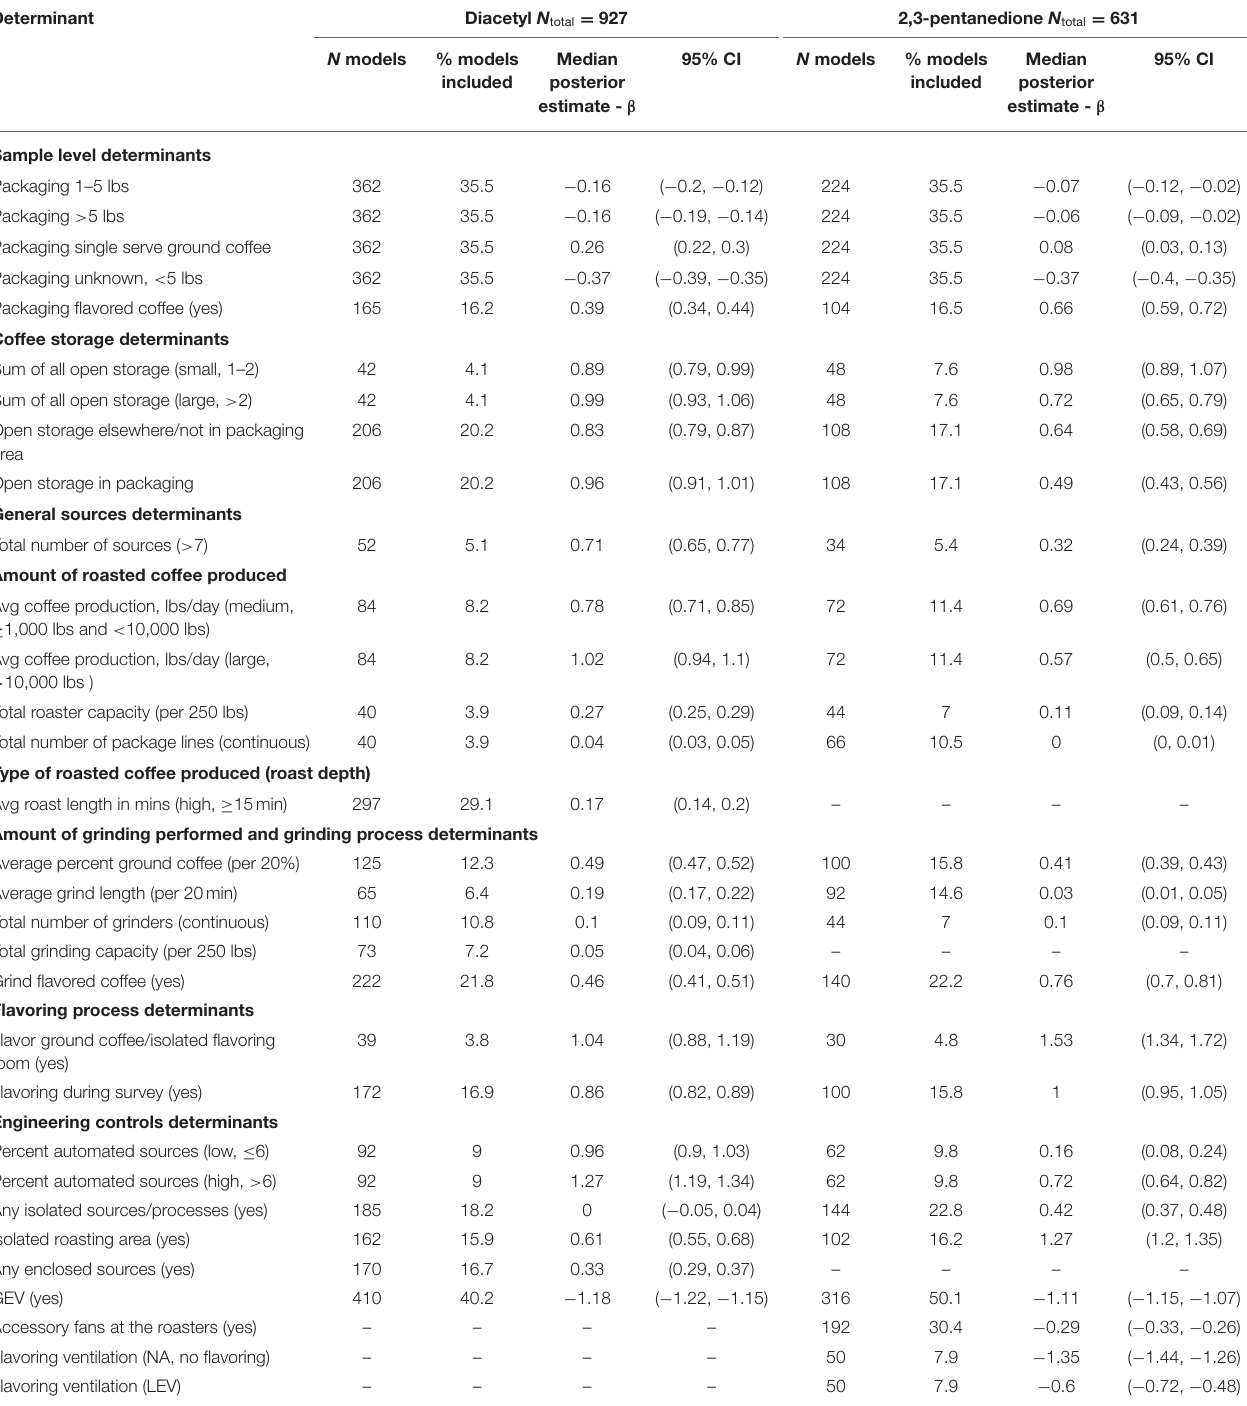
TABLE 5 | Bayesian model averaging results for diacetyl and 2,3-pentanedione exposures during packaging tasks. Determinant Diacetyl N total = 927 2,3-pentanedione N total =